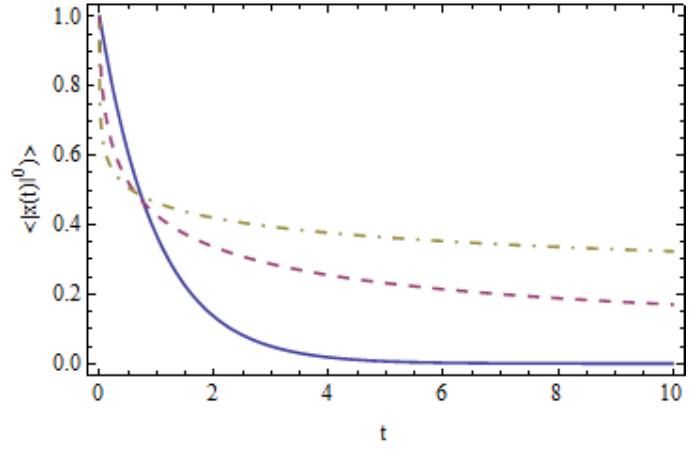
Figure 1. Graphical representation of 1  